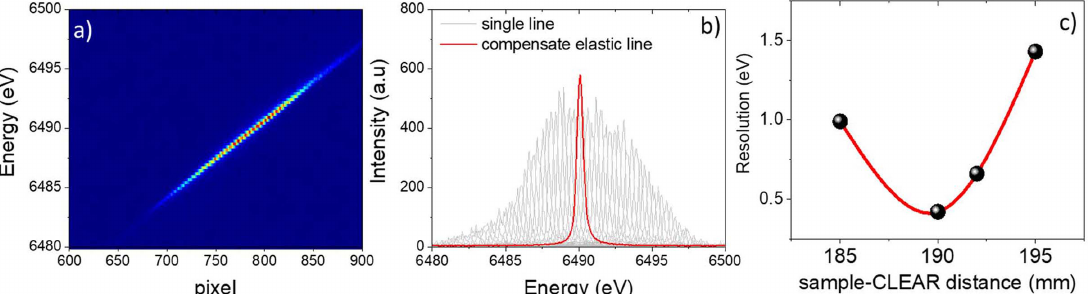
Figure 2 Elastic scan collected at the Mn K (cid:2) emission energy. ( a ) Bidimensional map showing the evolution of the analyzer reflection on the detector as a function of the incoming energy. ( b ) Evolution of the analyzer reflection on the detector as a function of the incoming energy, where the pixel–energy conversion has been already applied. The red curve is the elastic line once compensated, i.e. the weighted sum of all the individual contributions shifted to overlap to the center of the scan. ( c ) Evolution of the energy resolution as a function of the sample–CLEAR spectrometer